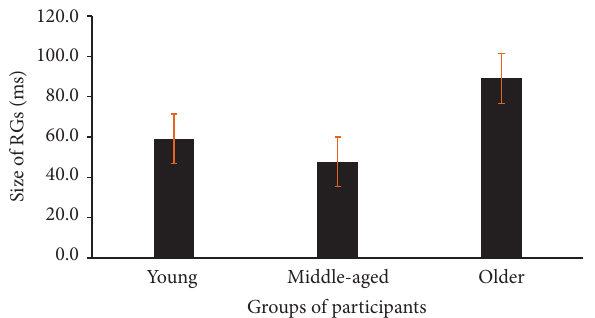
Figure 3: The size of the redundancy gains for groups of young, middle-aged, and older participants.